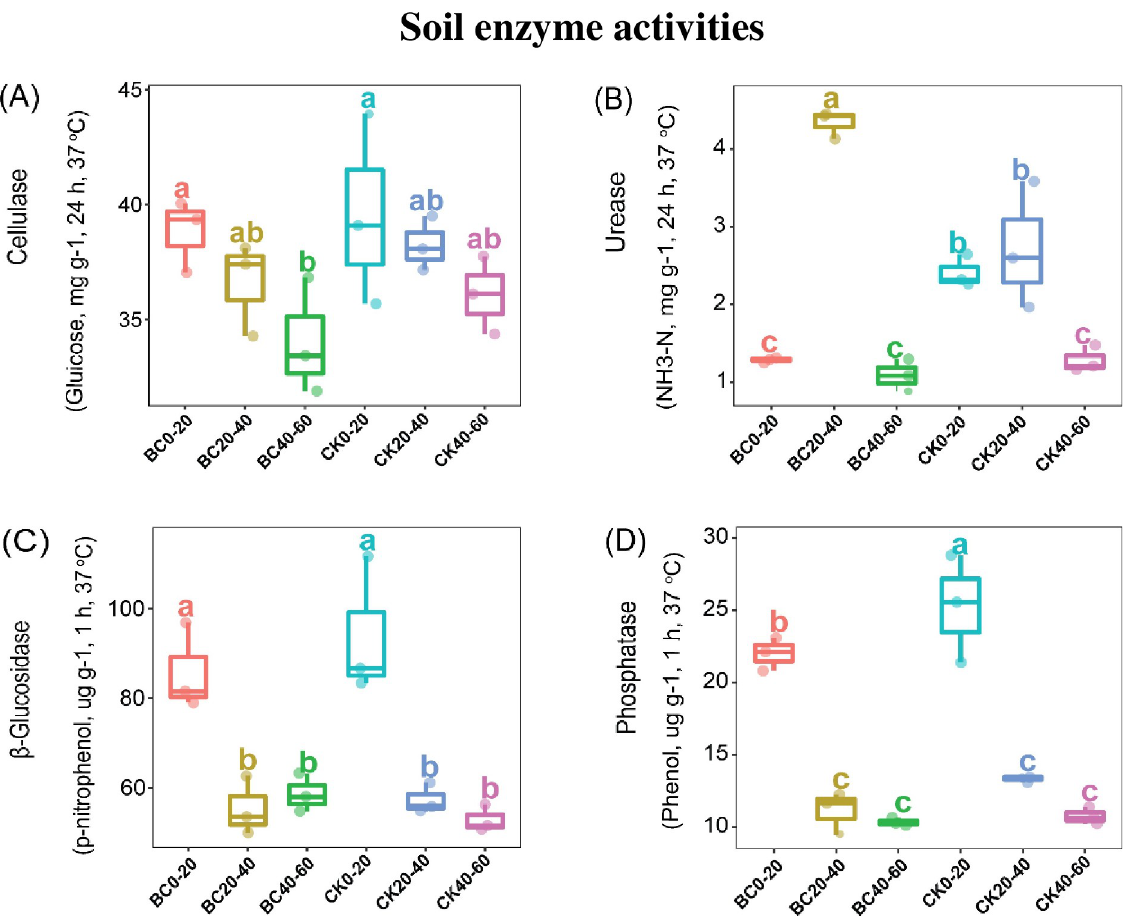
Fig 3. Soil enzymatic activities in different soil profiles. (A) cellulase activity, (B) urease activity, (C) β -Glucosidase, (D) acid phosphatase activity under BC, biochar amendment; compared to the CK, control at different soil depths. Boxplots with various lowercase letters indicate a significant difference between treatments based on Tukey’s HSD test ( p <